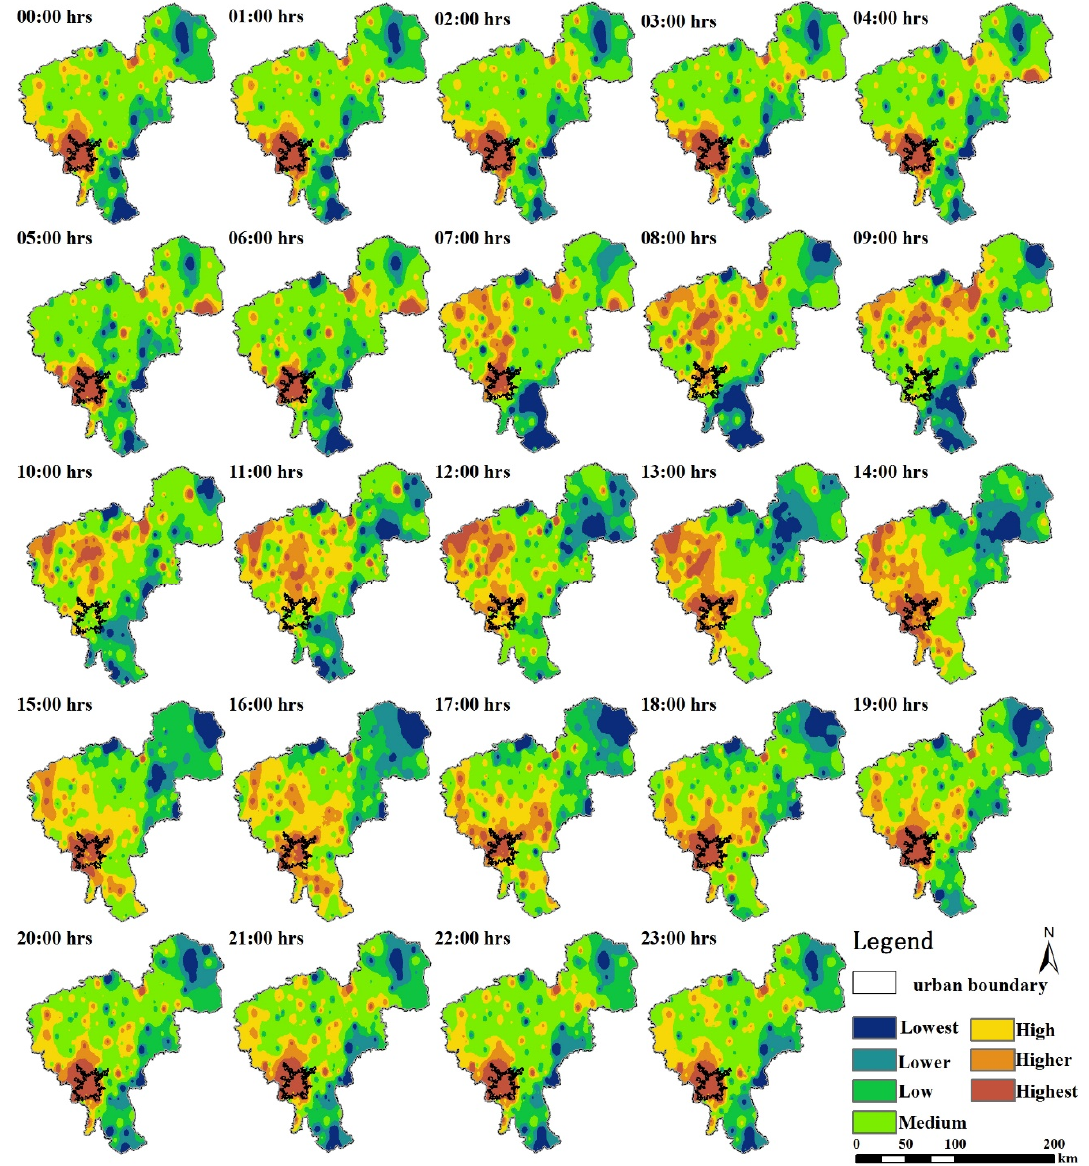
Figure 7. Mean hourly variations of air temperature for Changchun during August 1–31, 2015.